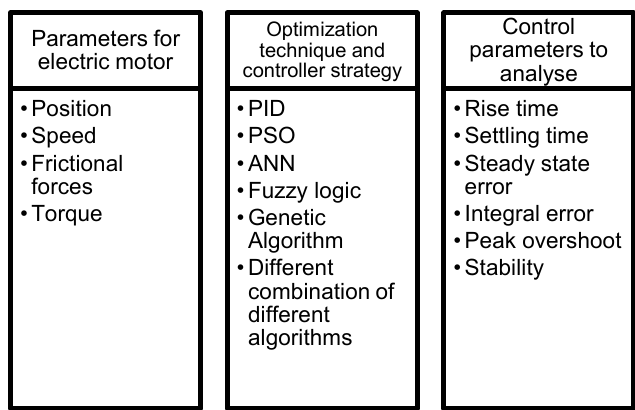
Figure 4. Outline of parameters associated with the electric motor used in medical